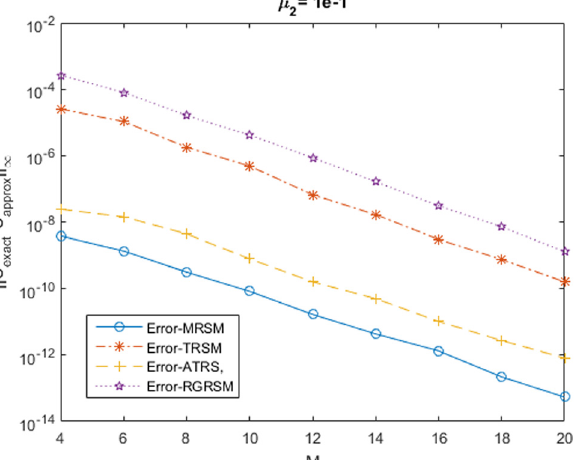
Figure 10: The absolute error of Example 4.2 for regularization parameters with